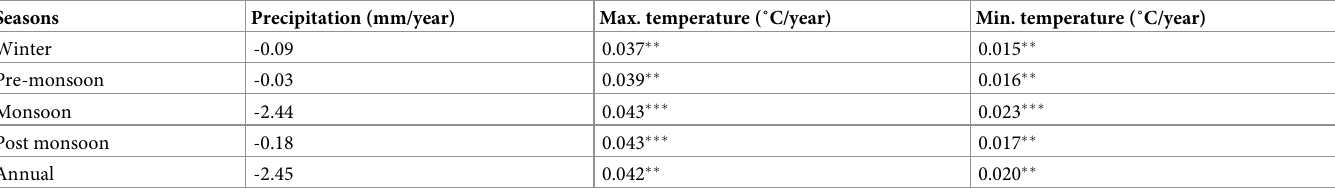
Table 1. Change in temperature and precipitation from 1971 to 2014 in Kavre